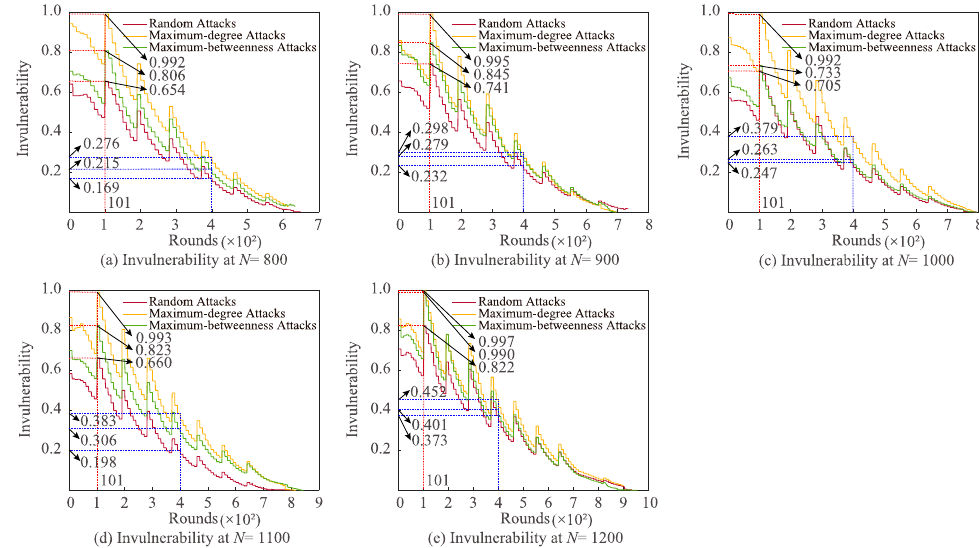
Figure 5. Influences of varying N on invulnerability for different attacks.